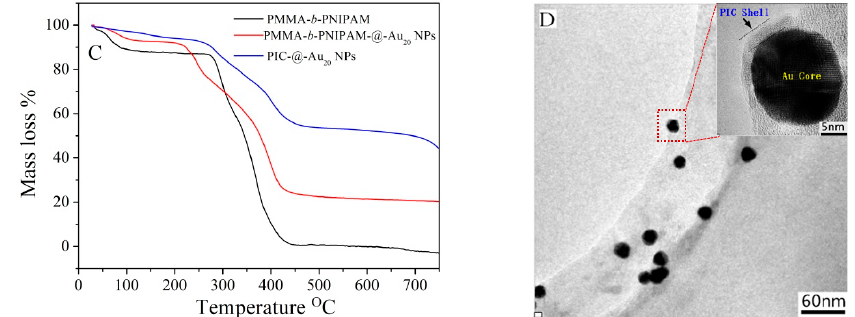
Figure 2. UV-Vis spectra ( A ) and hydrodynamic diameter distributions ( B ) of Au 20 NPs, PMAA- b -PNIPAm-@-Au 20 NPs and PIC-@-Au 20 NPs. TGA analysis of PMAA- b -PNIPAm, PMAA- b -PNIPAm-@-Au 20 and PIC-@-Au 20 NPs ( C ). TEM image of PIC-@-Au 20 NPs ( D ); the inserted image is a magnification of the NPs in ( D ).